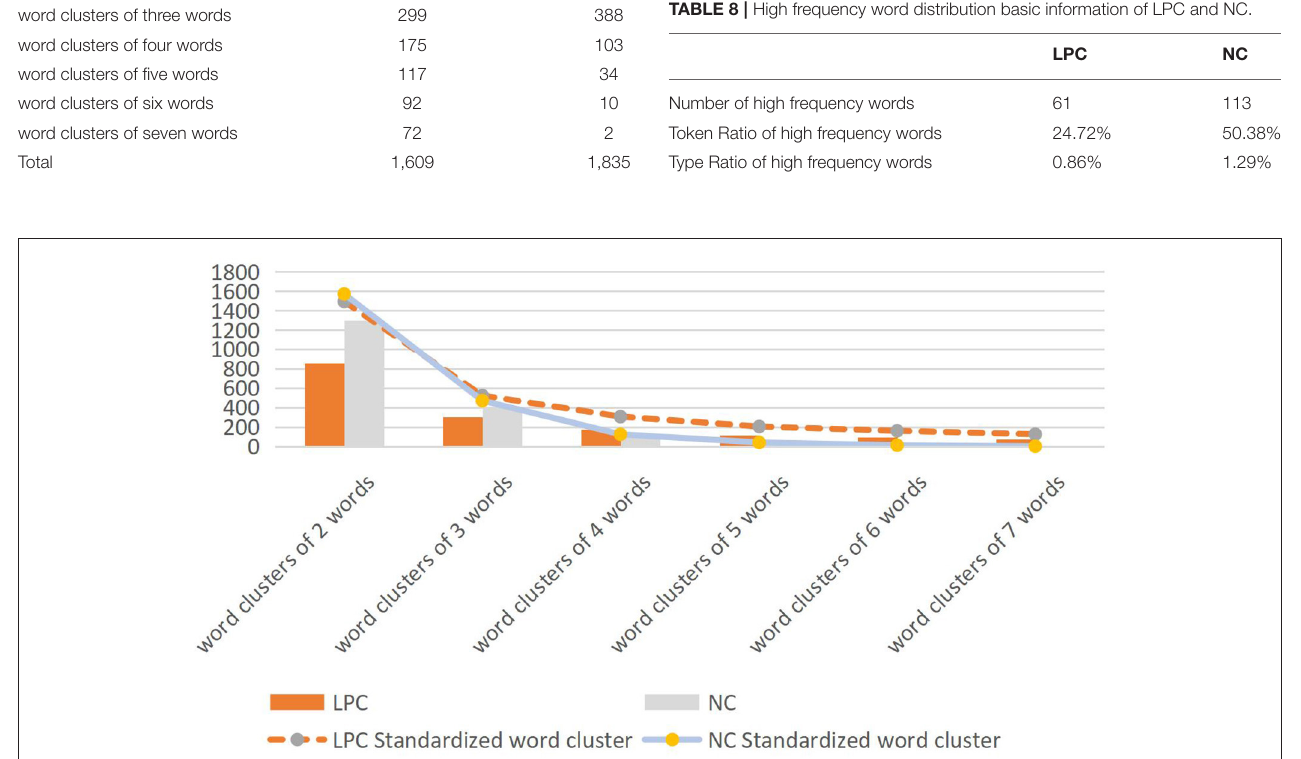
FIGURE 4 | The number of word clusters and the distribution of standardized word clusters.